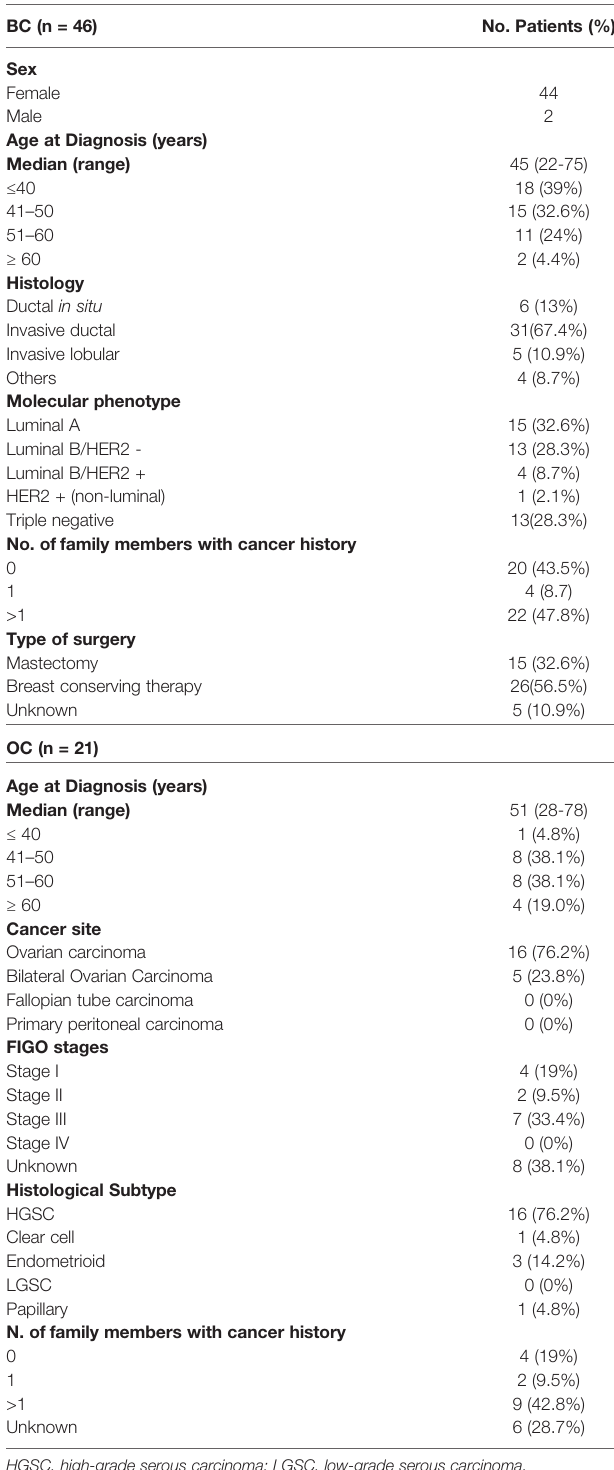
TABLE 1 | Clinico-pathological features of germline BRCA1/2 VUS carriers affected by BC or